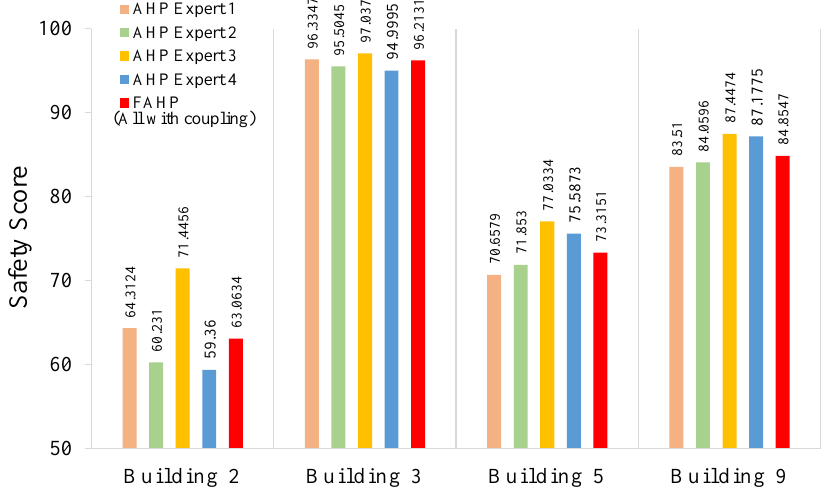
Figure 9. The safety score results obtained by the AHP with coupling revision and the FAHP with coupling